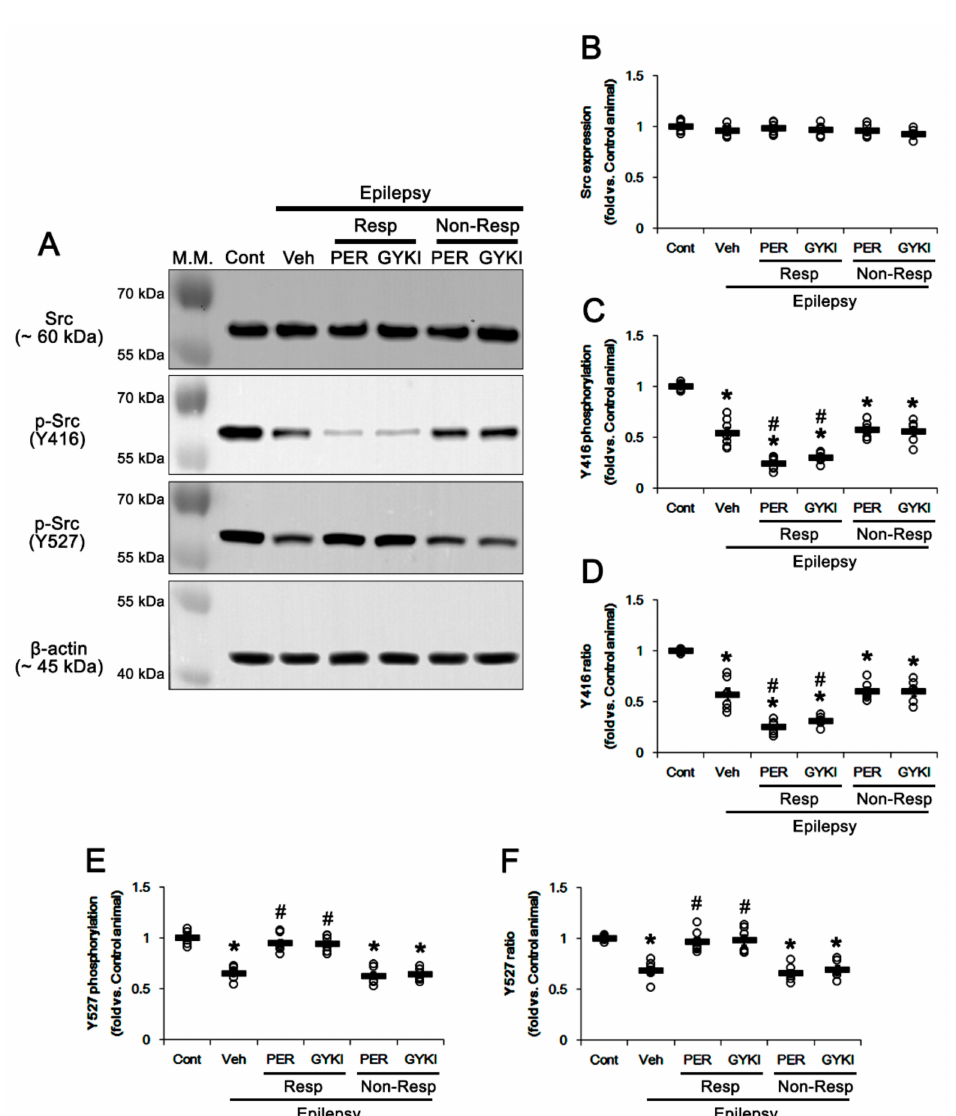
Figure 5. The effects of perampanel (PER) and GYKI 52466 (GYKI) on Src family and its phosphorylations in chronic epilepsy rats. ( A ) Representative images for Western blot of Src family and its phosphorylation levels in the hippocampal tissues. ( B – F ) Quantifications of Src2 ( B ), p-Src Y416 ( C ), p-Src Y416/Src ratio ( D ), p-Src Y527 ( E ), and p-Src Y527/GRIA2 ratio ( F ) in the hippocampal tissues. Open circles indicate each individual value. Horizontal bars indicate mean value. Error bars indicate SEM ( *, # p < 0.05 vs. control (Cont) and vehicle (Veh)-treated animals, respectively; one-way ANOVA with post hoc Bonferroni’s multiple